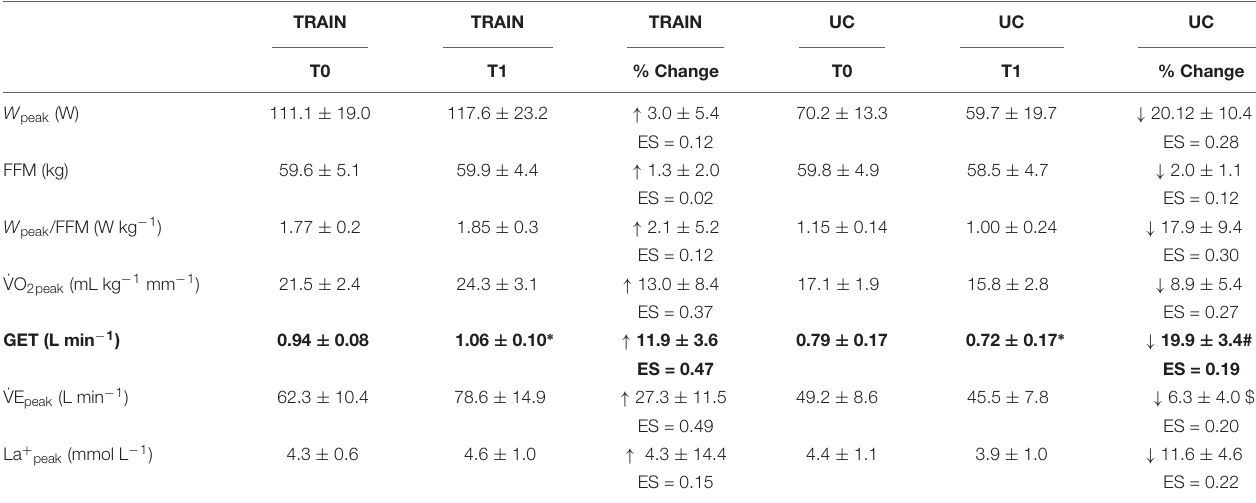
TABLE 2 | Mean values before (T0) and after (T1) 12 weeks of exercise training (TRAIN) and usual care (UC), and percentage changes of different variables measured during a cardiopulmonary exercise test (CPET). TRAIN TRAIN TRAIN UC UC UC T0 T1 % Change T0 T1 %